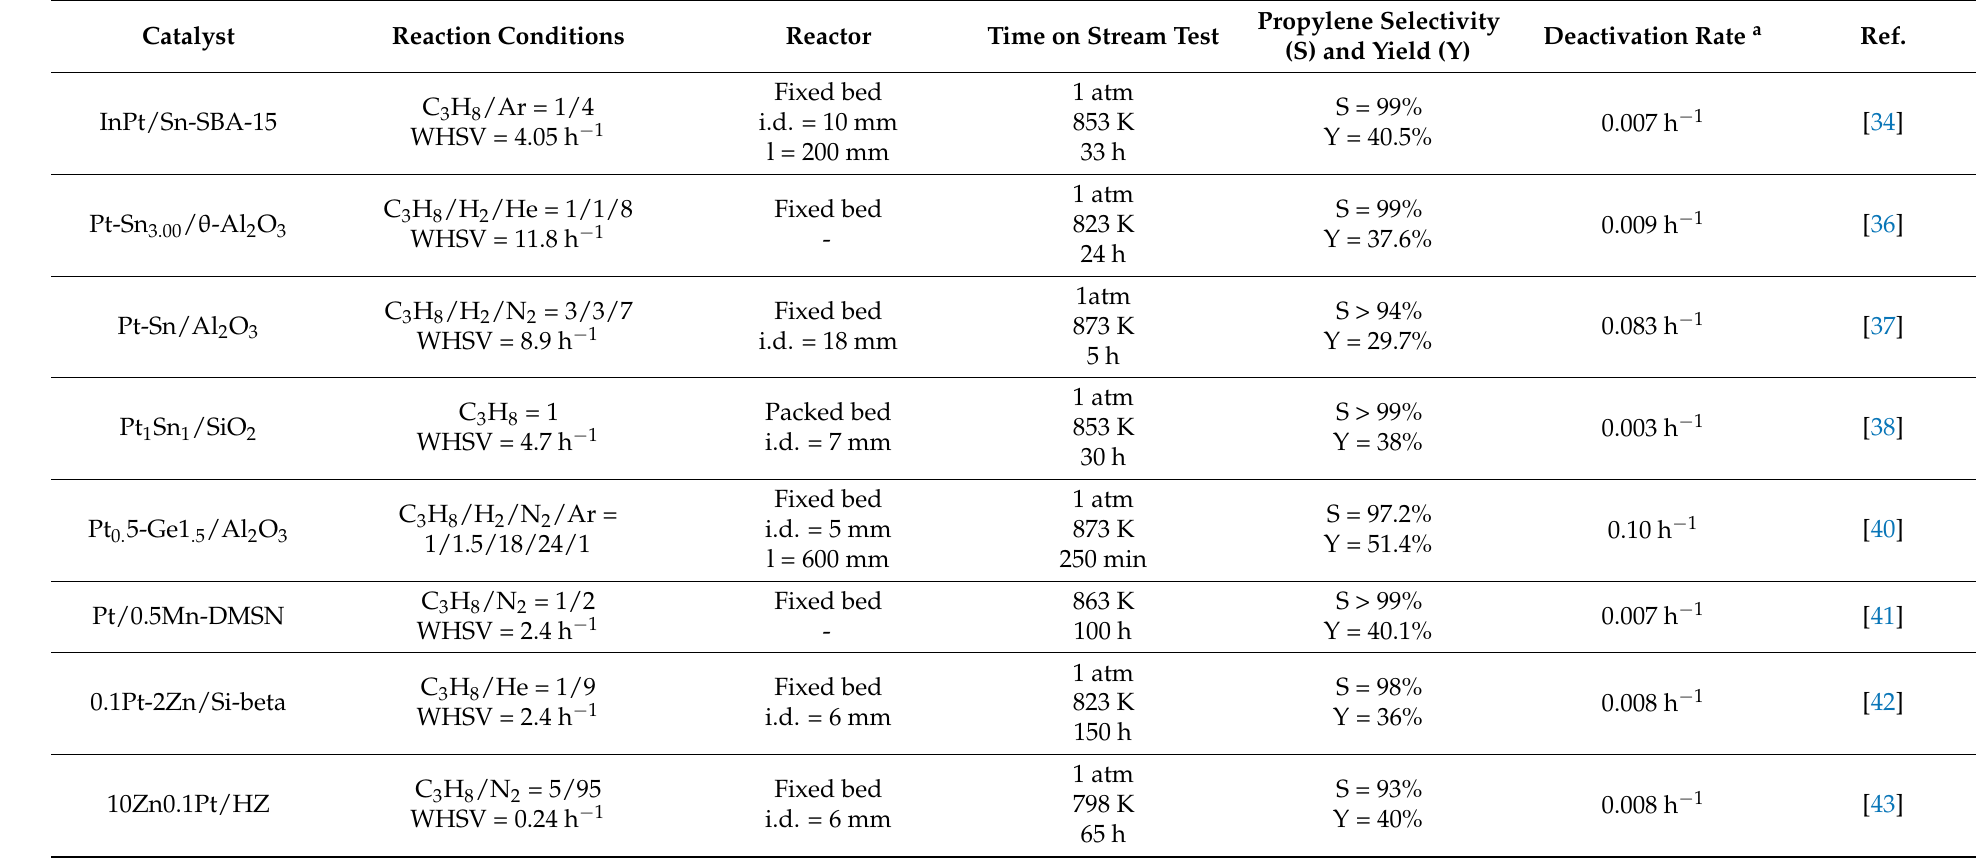
Table 1. Polymetallic and promoted catalysts: reaction conditions, propylene selectivity, propylene yield and deactivation rate per selected catalyst of each